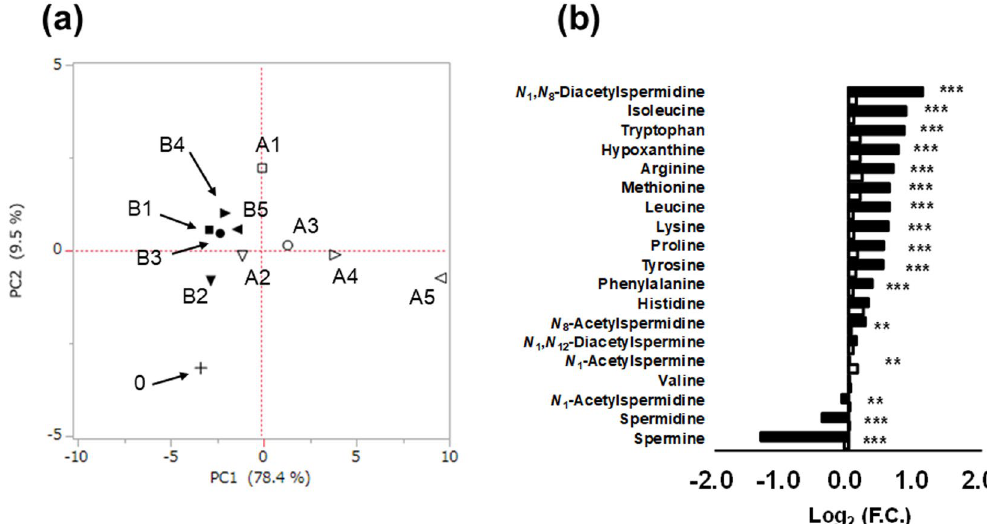
Figure 3. Metabolite concentration change in the short-term storage test. ( a ) Score plots of principal component (PC) analysis. The PC1 and PC2 indicated the first and the second PC. The contributions for PC1 and PC2 were 78.4 and 9.5%, respectively. Labels corresponded to Fig. 1a. ( b ) Log 2 values of fold change of metabolite concentrations after 240 min. Black and white indicate storage at room temperature (RT) and on ice (OI), respectively, corresponding to A5/0 and B5/0 in Fig. 1a. ** P < 0.01 and P < 0.001 (Student’s t-test, both